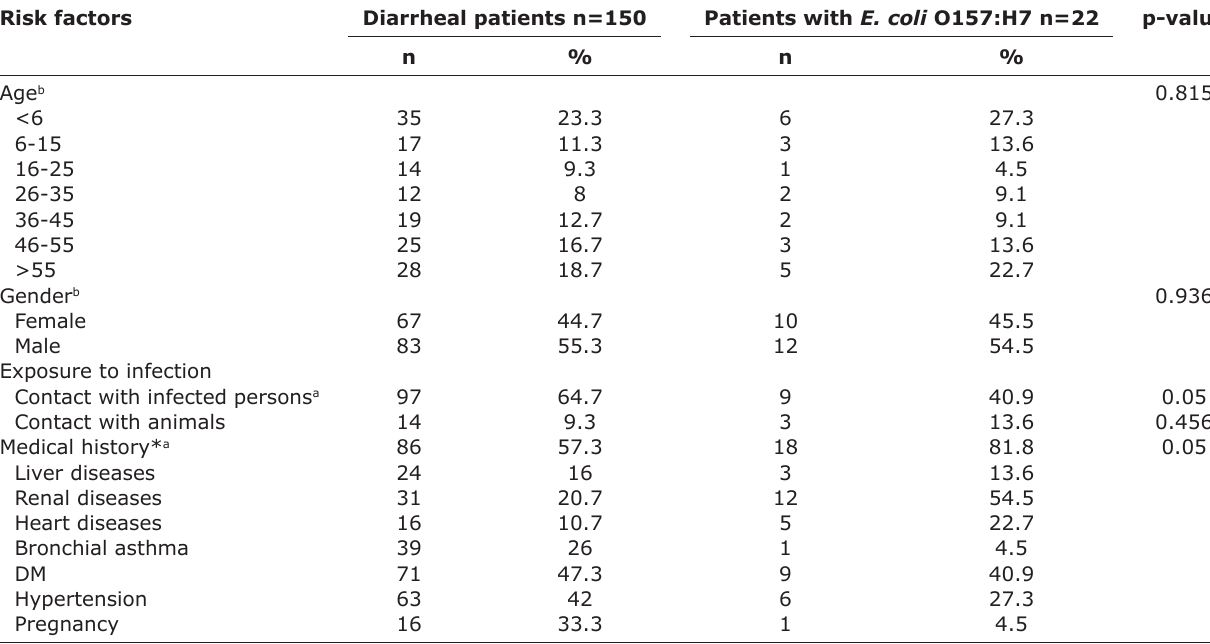
Table-2: Patient characteristics and factors related to infection with E. coli O157:H7. Risk factors